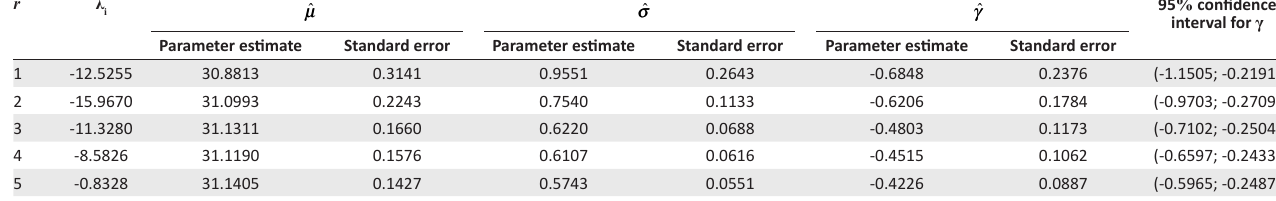
, parameter estimates ˆ, ˆ, and ˆ µ σ i